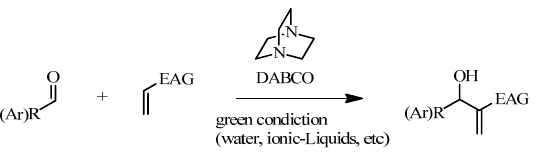
Figure 1. The leishmanicidal activity of hybrids 1 and 5 and their precursors. The analgesic/anti ‐ inflammatory 6 and 7 .